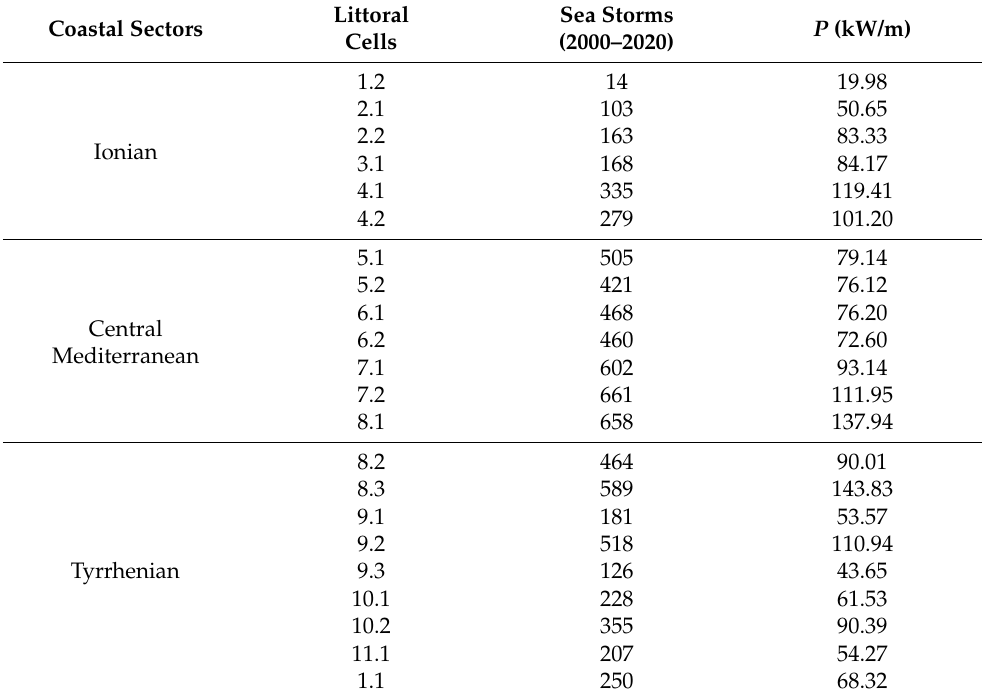
Table 2. Computed values of the sea state for each Sicilian macro sector. Coastal Sectors